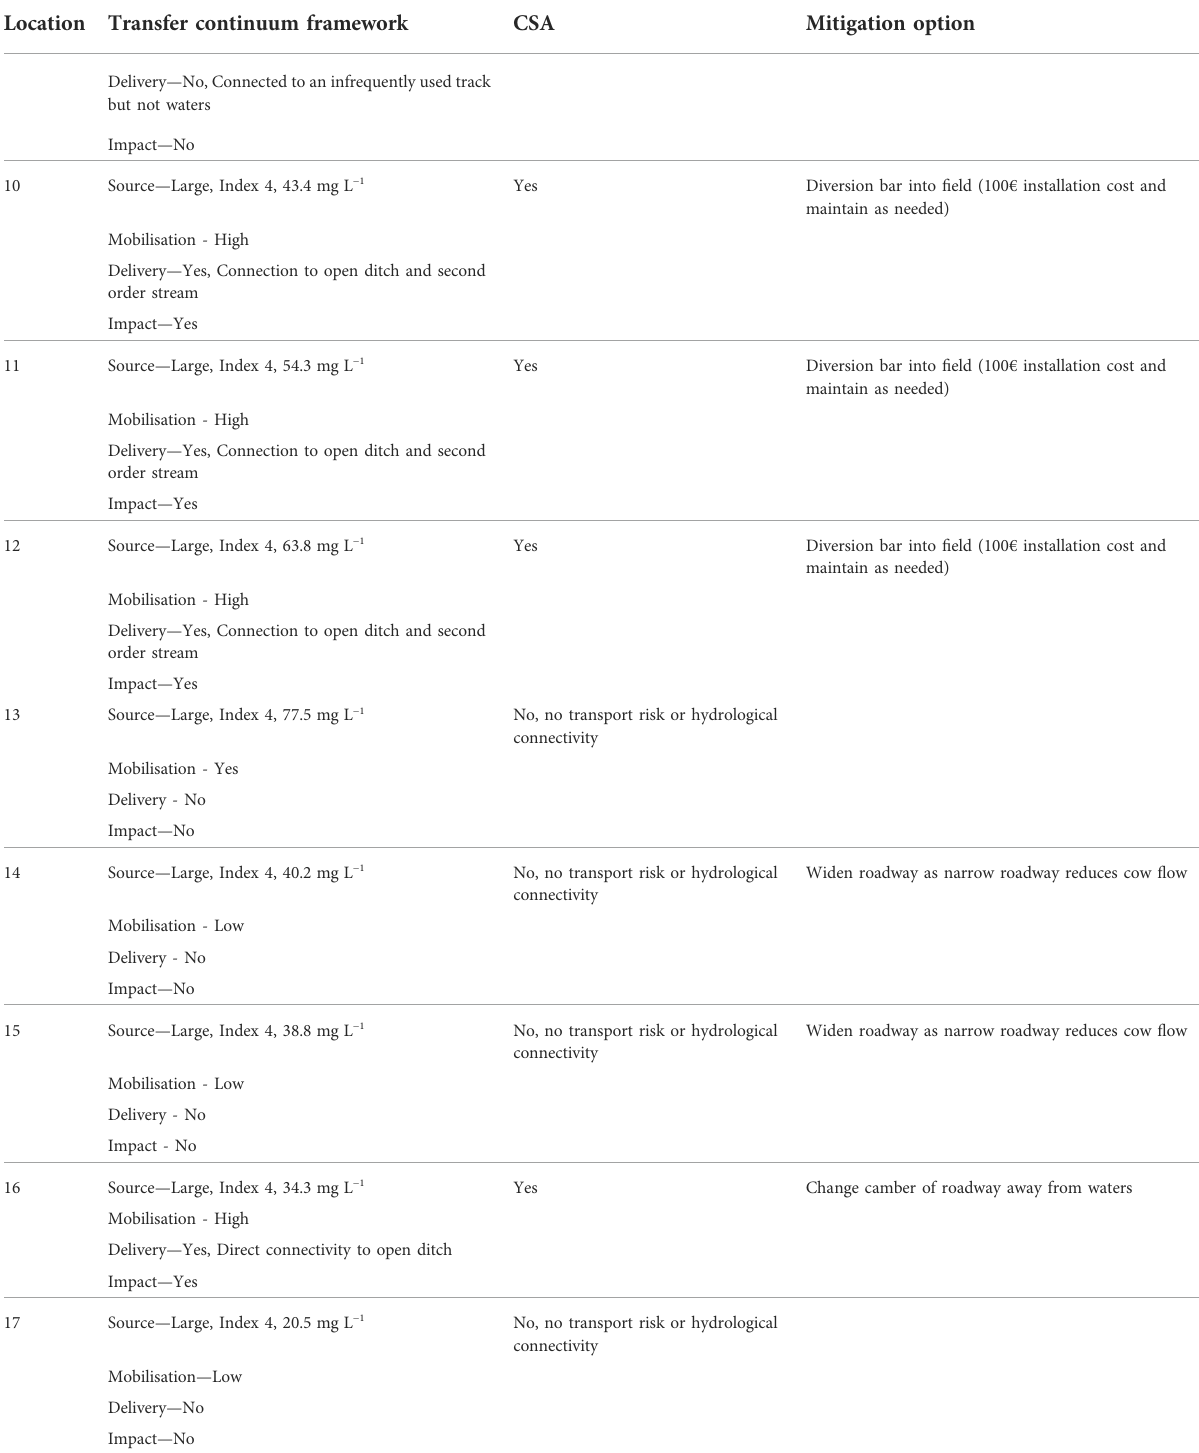
TABLE 4 ( Continued ) Phosphorus component of Nutrient Transfer Continuum Framework for each location, Critical Source Area (CSA) and Mitigation Options. All concentrations refer to Morgan ’ s